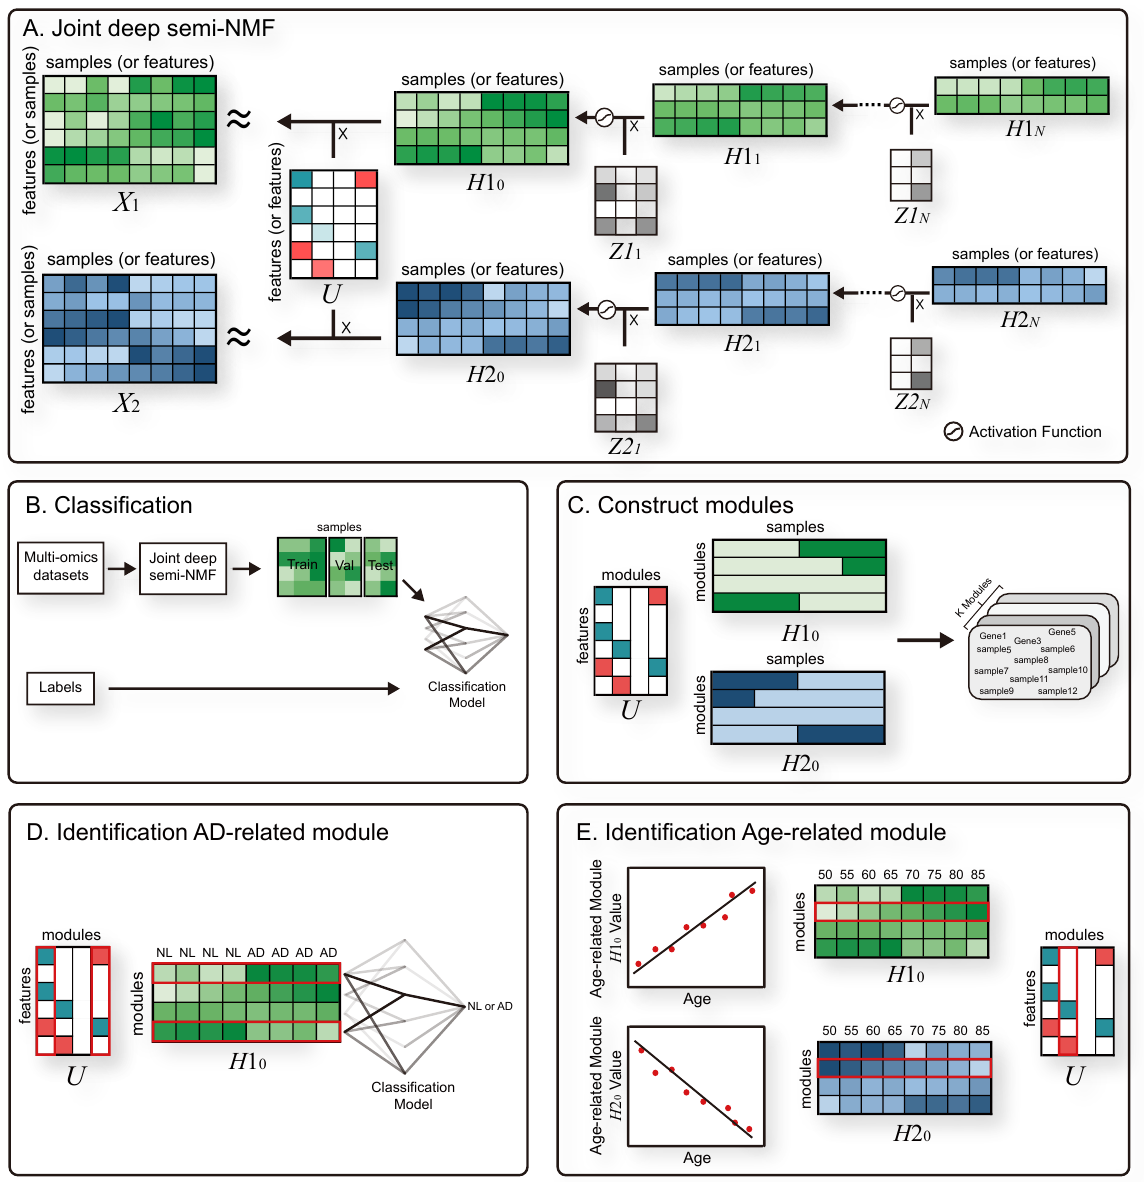
Figure 1. Joint deep-semi NMF (JDSNMF) overview and downstream analyses. ( A ) Model overview: JDSNMF decomposes feature-matched (or sample-matched) multiple data. Taking Alzheimer’s disease experiments as an example,